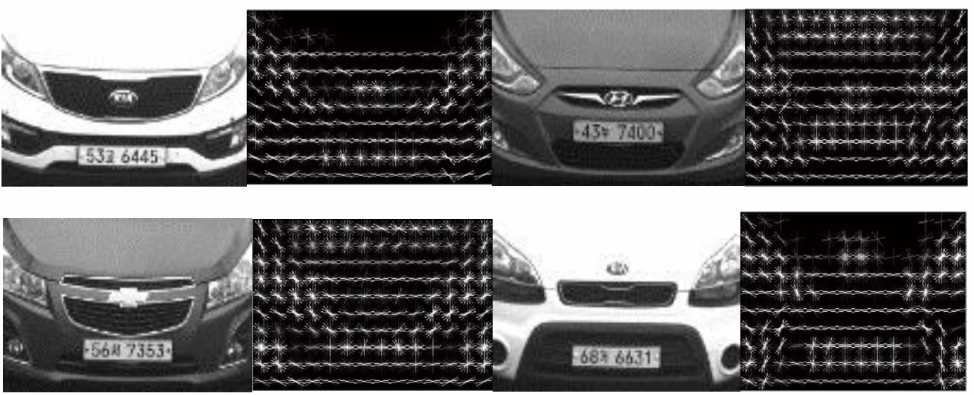
Figure 10. HOG features of frontal view of vehicle image, cell size was set to 8 ˆ 8, and the size of the HOG features is 10 ˆ 14 ˆ 36.